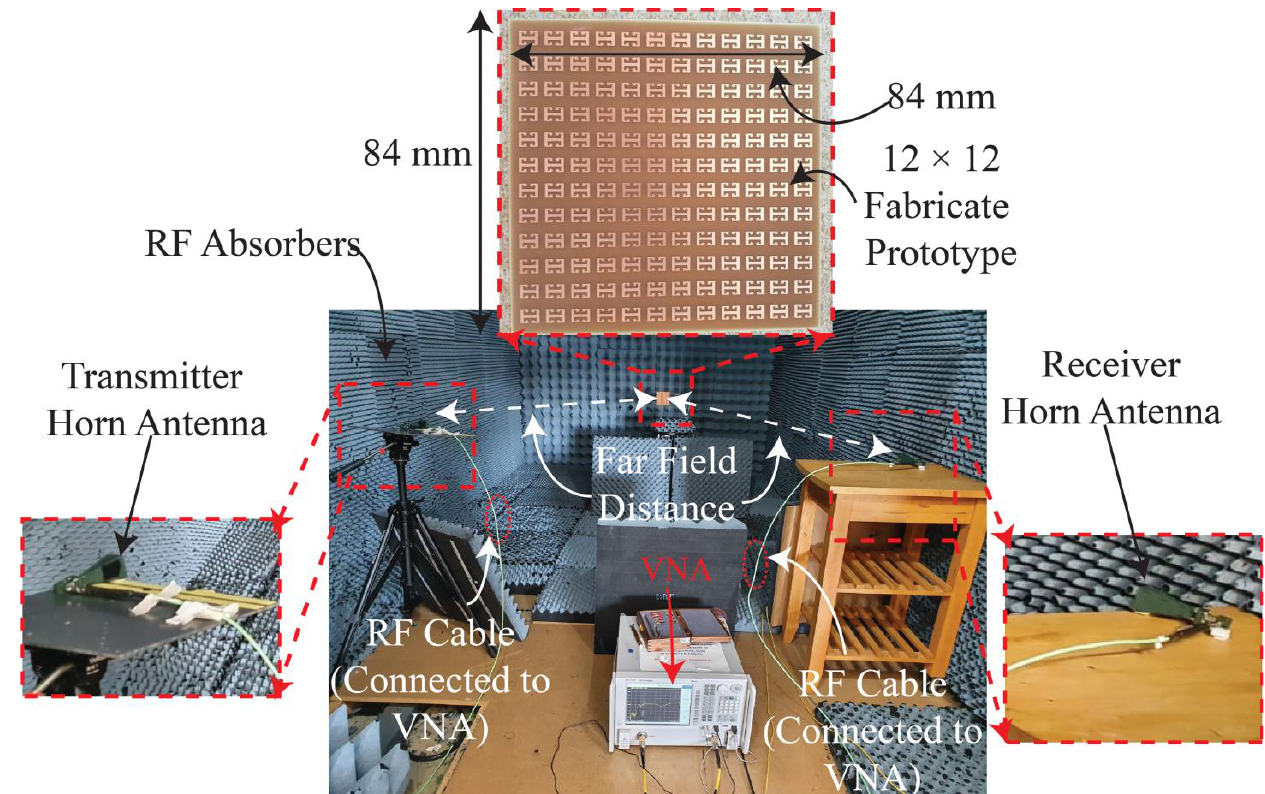
Figure 9. A photograph of the fabricated prototype and experimental setup used for the measure- ment of the proposed